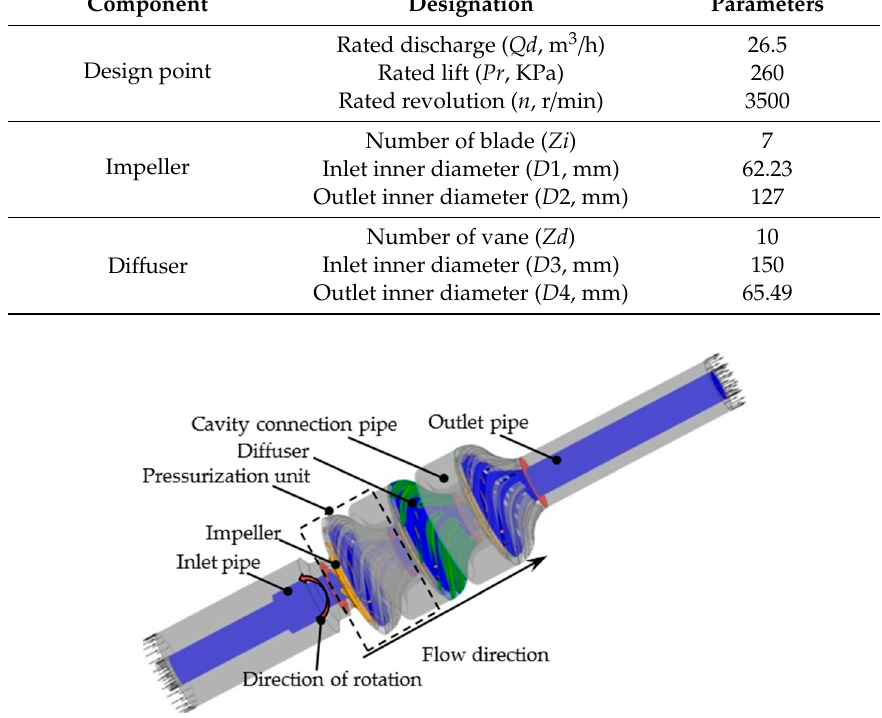
Figure 1. Calculation domain of the three stages of the multiphase pump.